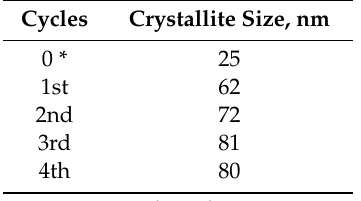
Table 2. Evolution of Ni crystallite size of the catalyst regenerated in five consecutive reaction- regeneration cycles.